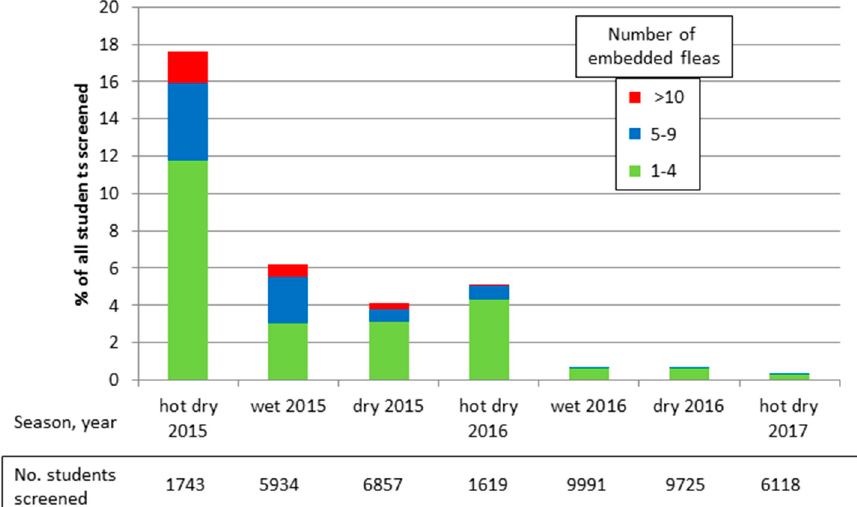
Figure 4. Period prevalence and intensity of tungiasis in target schools.